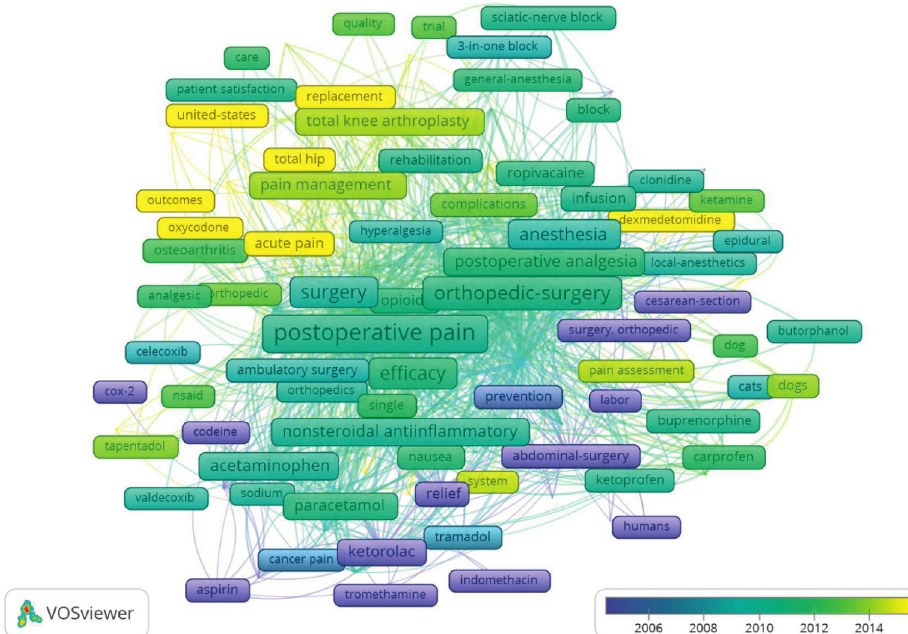
Figure 7: Keywords co-occurrence overlay mapping on analgesics in the treatment of orthopedic postoperative pain. Each frame indicates a keyword. The rainbow color marks the average publication year from violet (further year) to yellow (recent year) in the range of spectrum. The larger scale of a keyword is according to the higher frequency, while the closer distance between the two keywords represents the stronger